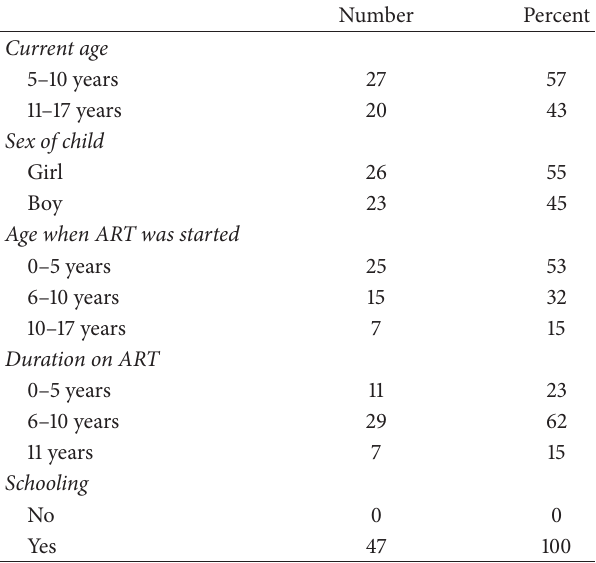
Table 2: Demographic and clinical variables of perinatal infected